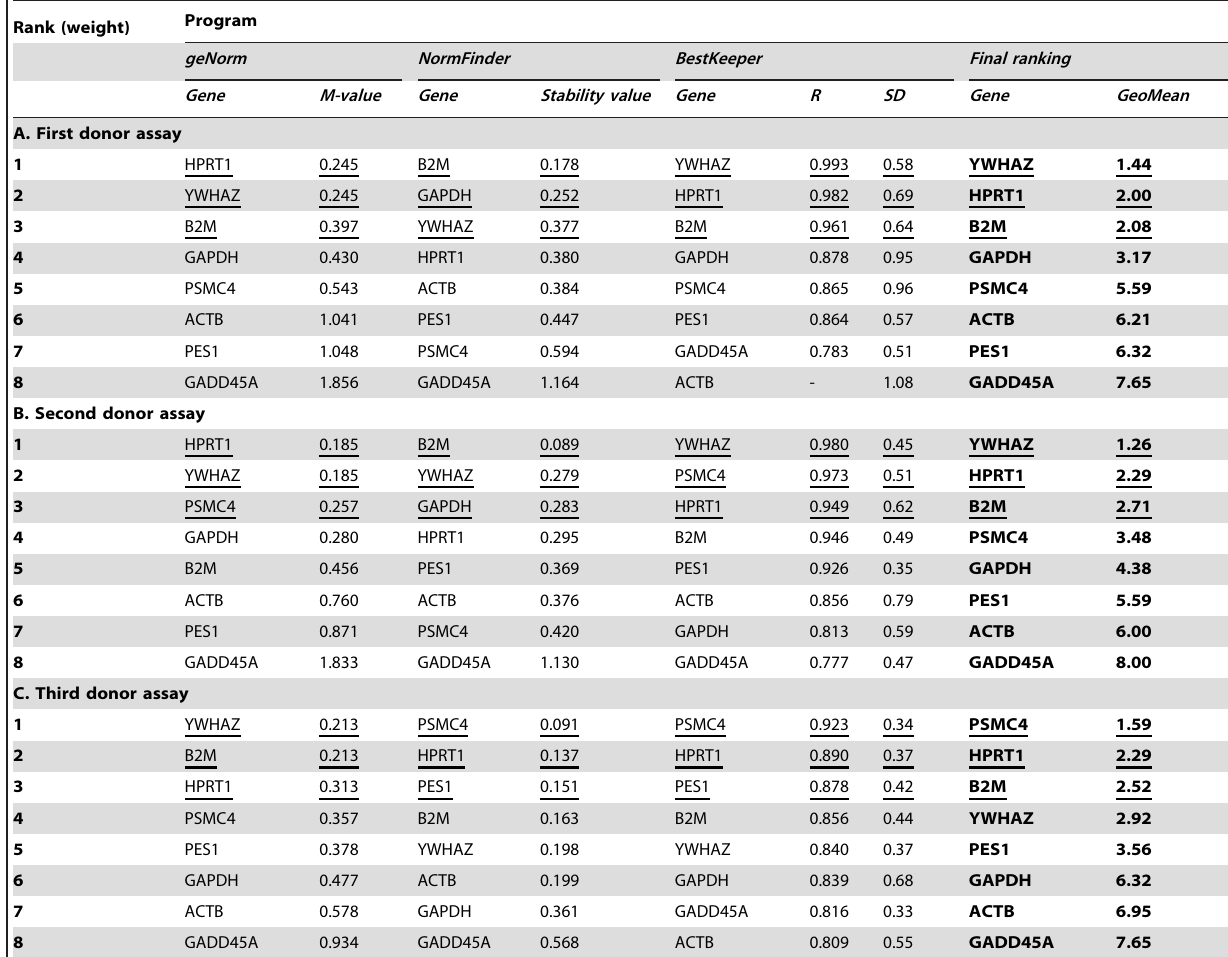
Table 3. Overall comparison of putative reference genes’